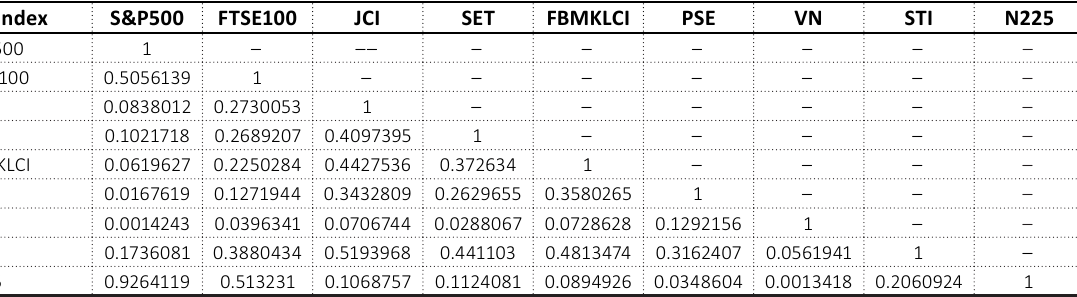
Table 9. Dynamic correlation generalized autoregressive conditional heteroskedasticity (DCC- GARCH(1,1)) estimates (minimum of correlations)